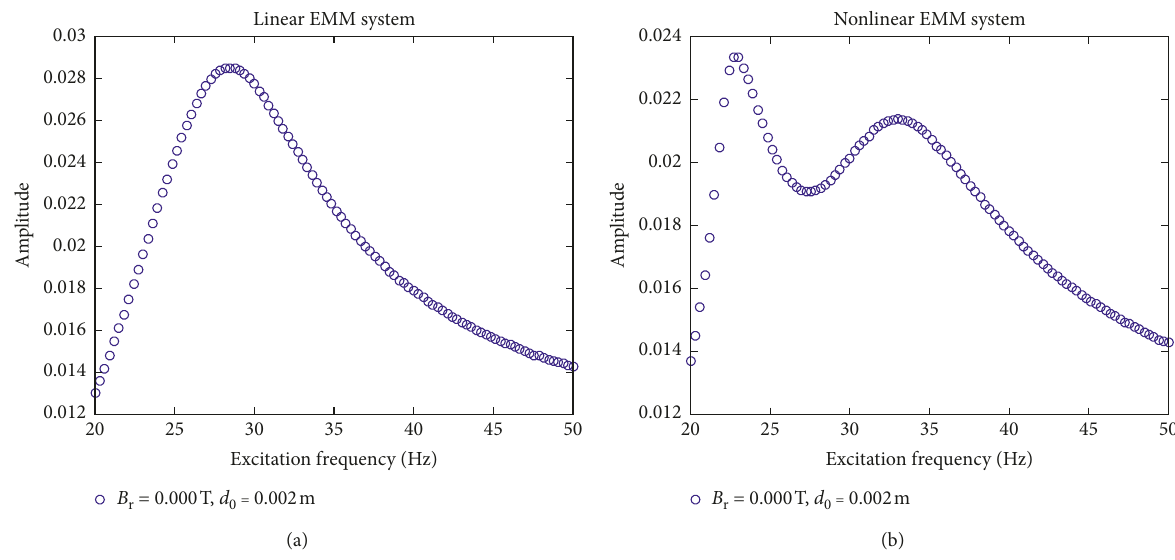
Figure 7: Analysis of the resonance frequency on the (a) linear and (b) nonlinear